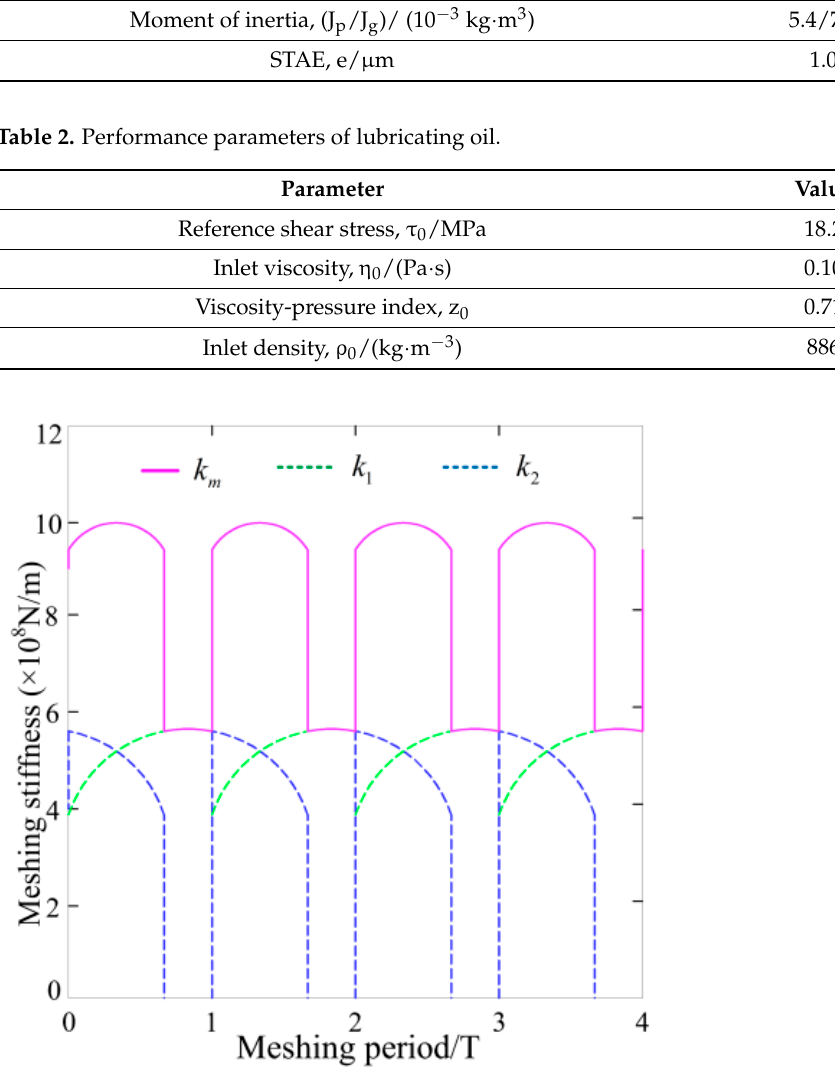
Figure 7. Each MGP and its TMS curves.